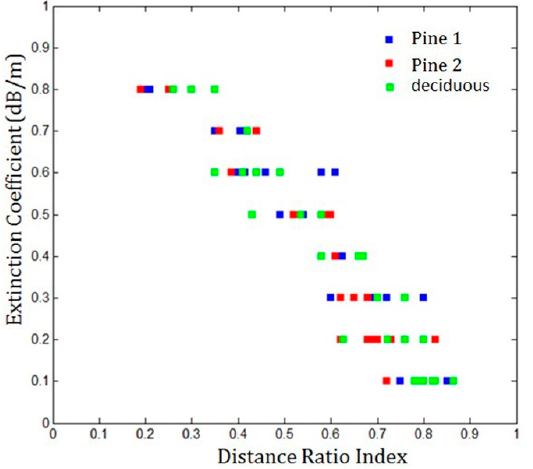
Figure 10. The mean extinction coefficient versus distance ratio index scatterplot. The scatterplot has been generated using three different forest species (i.e., deciduous and two types of pine); in three simulated PolInSAR data [7].